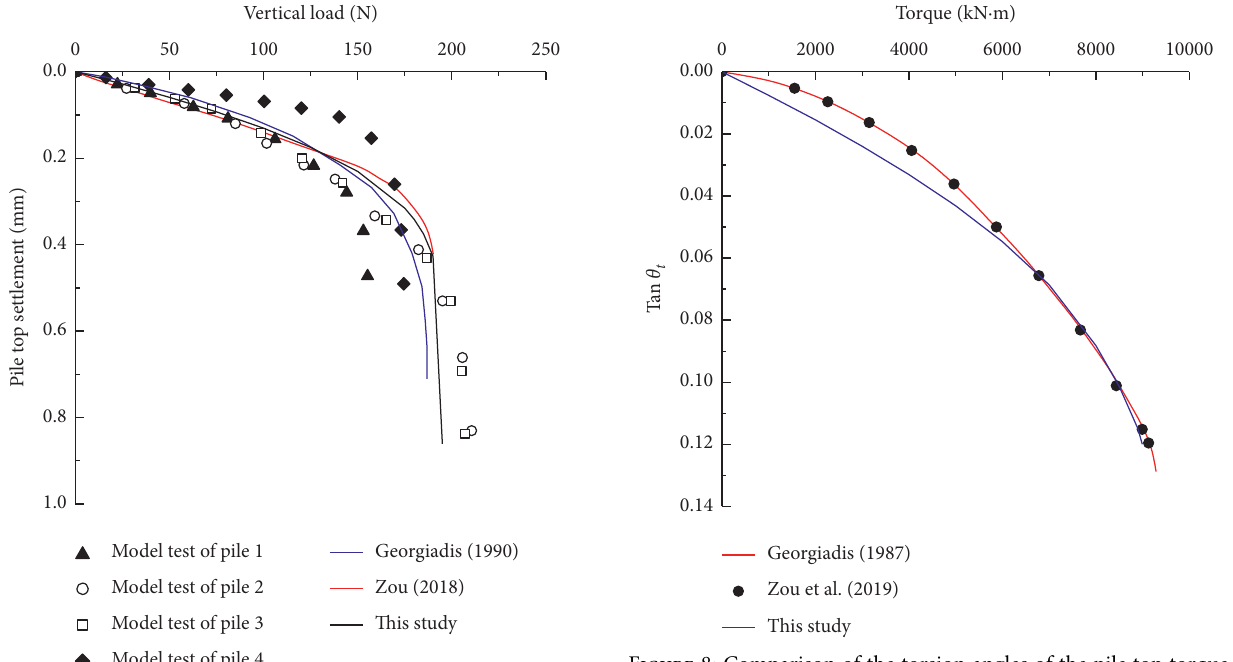
Figure 8: Comparison of the torsion angles of the pile top torque under the V ⟶ T loading path. Figure 7: Comparison of the vertical force and settlement of the